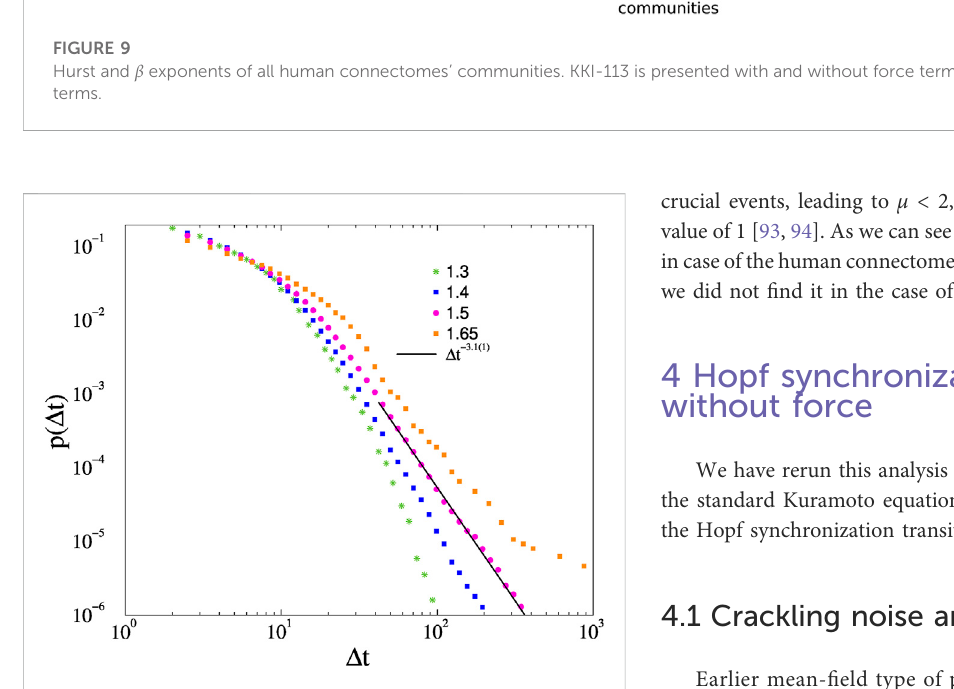
FIGURE 10 Avalanche duration distributions on the fruit- fl y connectome without force for K different couplings. The line shows a PL fi t for the K = 1.5 results, for Δ t >